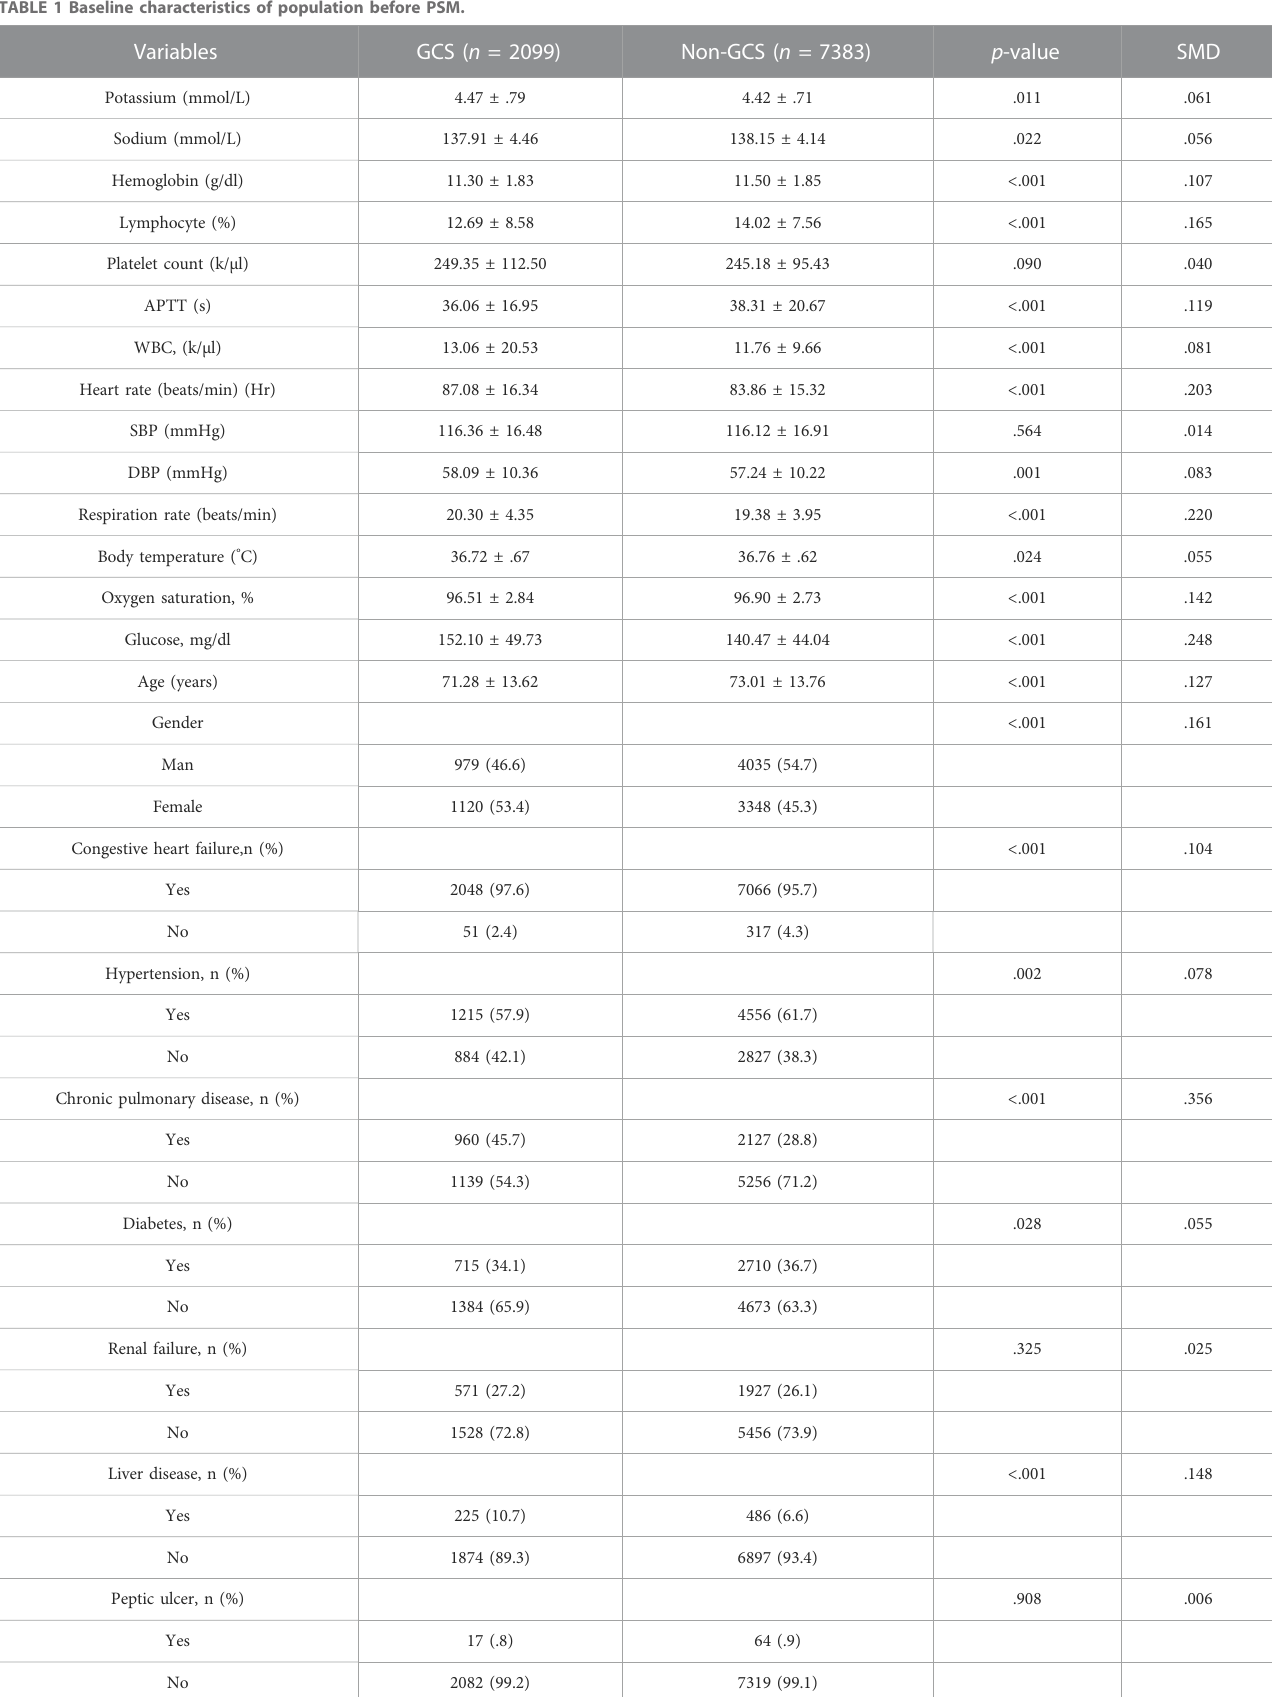
TABLE 1 Baseline characteristics of population before